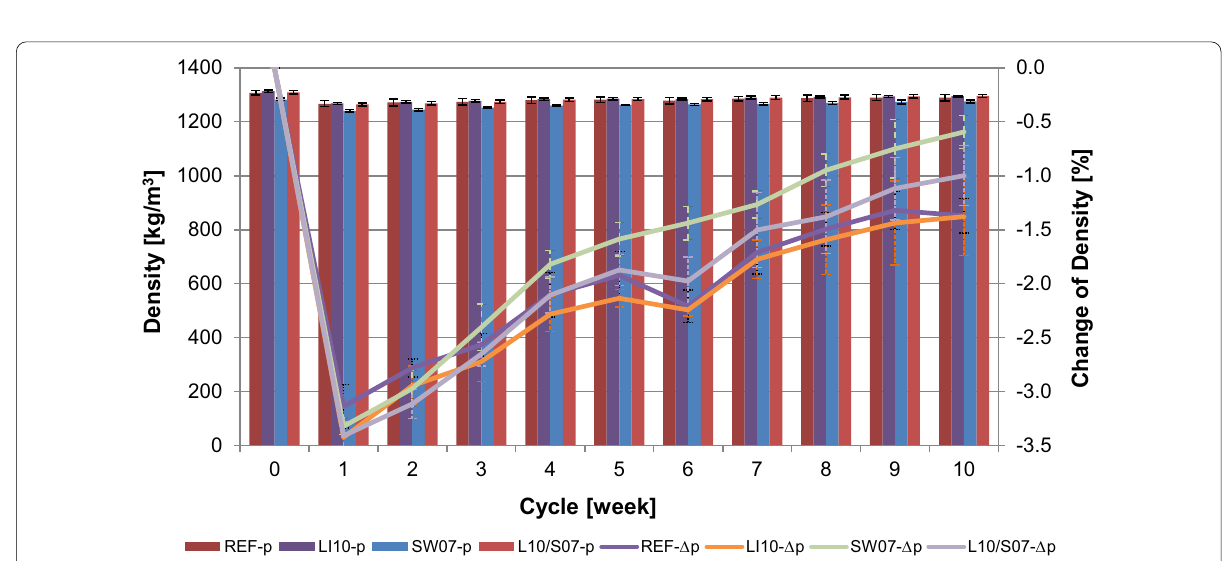
Fig. 13 Comparison of density changes of cement-bonded particleboards exposed to wet–frost–dry cycling according to EN